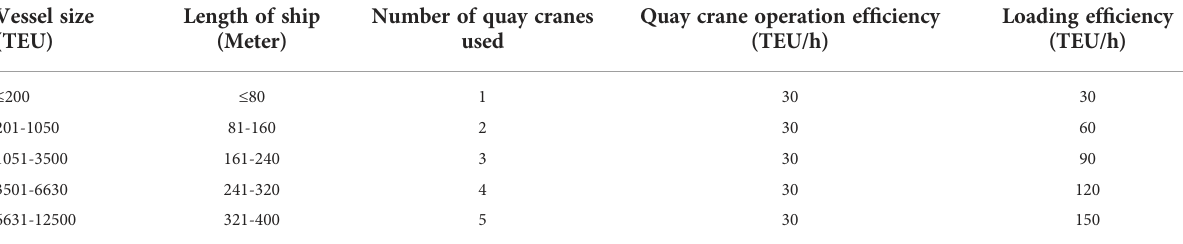
TABLE 5 Loading ef fi ciency value. Vessel size (TEU)